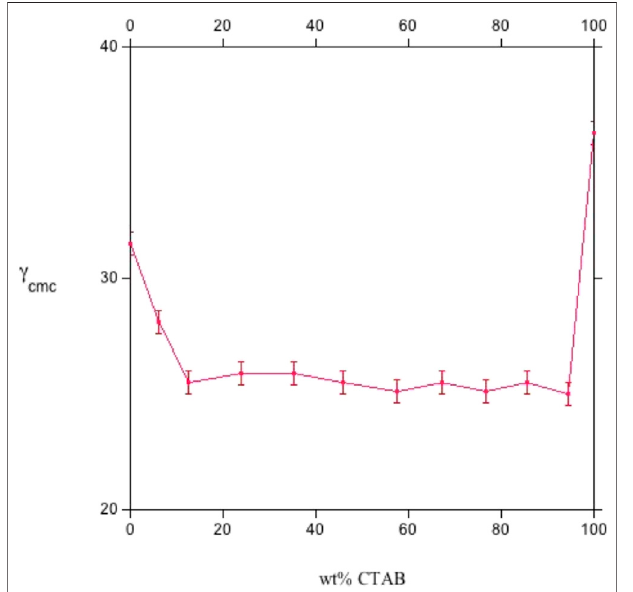
FIGURE6| Plotoftheinteractionparameters, β surf, and mic ,respectively, at the cmc , vs. the CTAB wt% in the system sodium octylsulfate/ cetyltrimethylammonium bromide at 25.0 ° C. ß parameters are in kJ mol − 1 . β β surf , in blue, is always more negative than mic . The plot was drawn by elaborating the data given in Ref. (Comelles et al.,